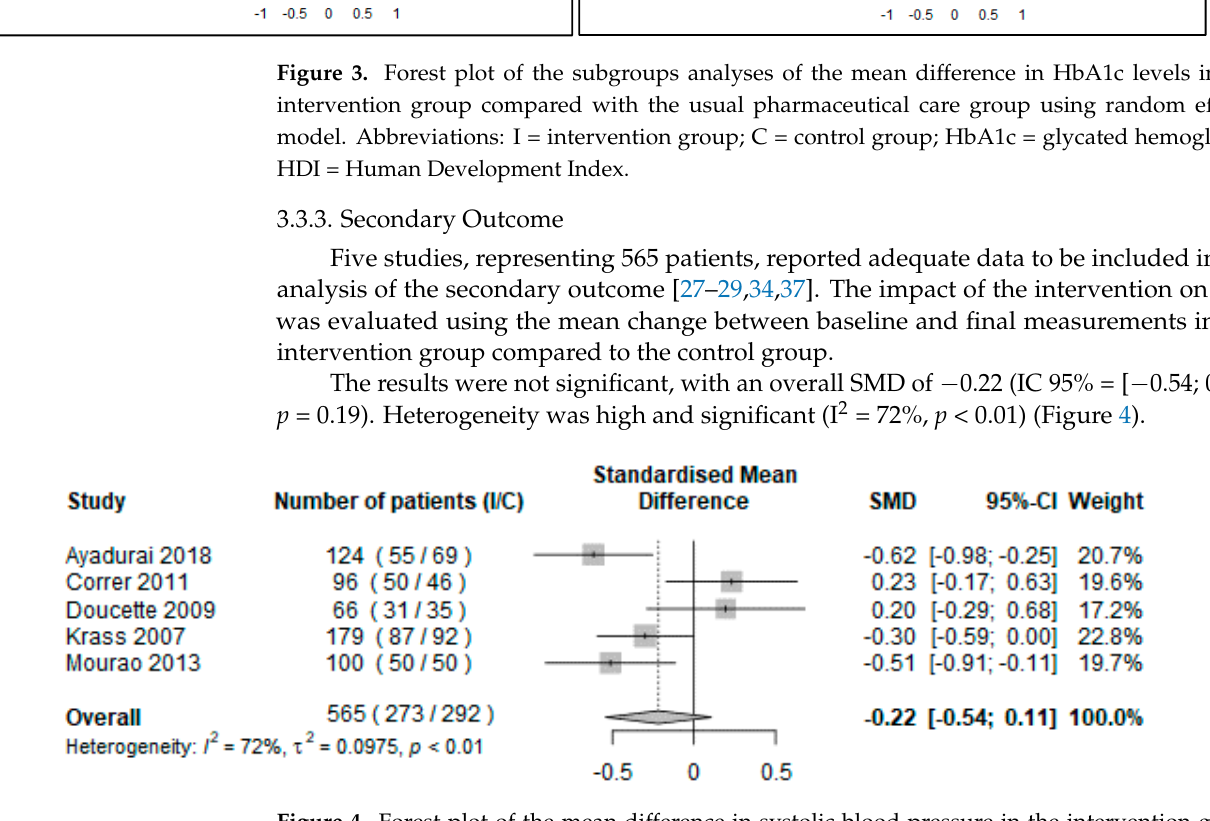
Figure 4. Forest plot of the mean difference in systolic blood pressure in the intervention group compared with the usual pharmaceutical care group using random effects model. Abbreviations: I = intervention group; C = control group; HbA1c = glycated